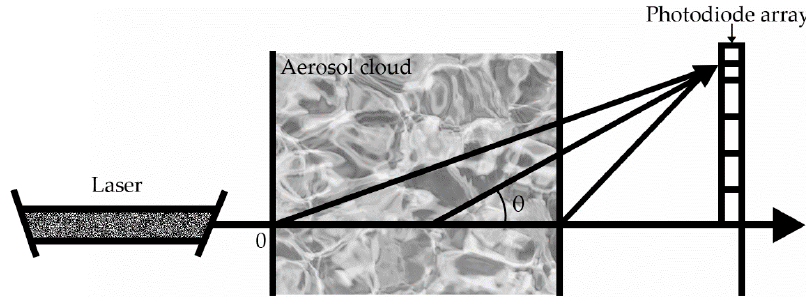
Figure 7. Scheme of interaction of laser radiation with an aerosol. The emitter is a helium-neon laser LG-78 with a wavelength of 0.63 µm. A photodiode array of seven FD-24K silicon photodiodes reg- isters scattering in the range of angles θ = (0–15)° .